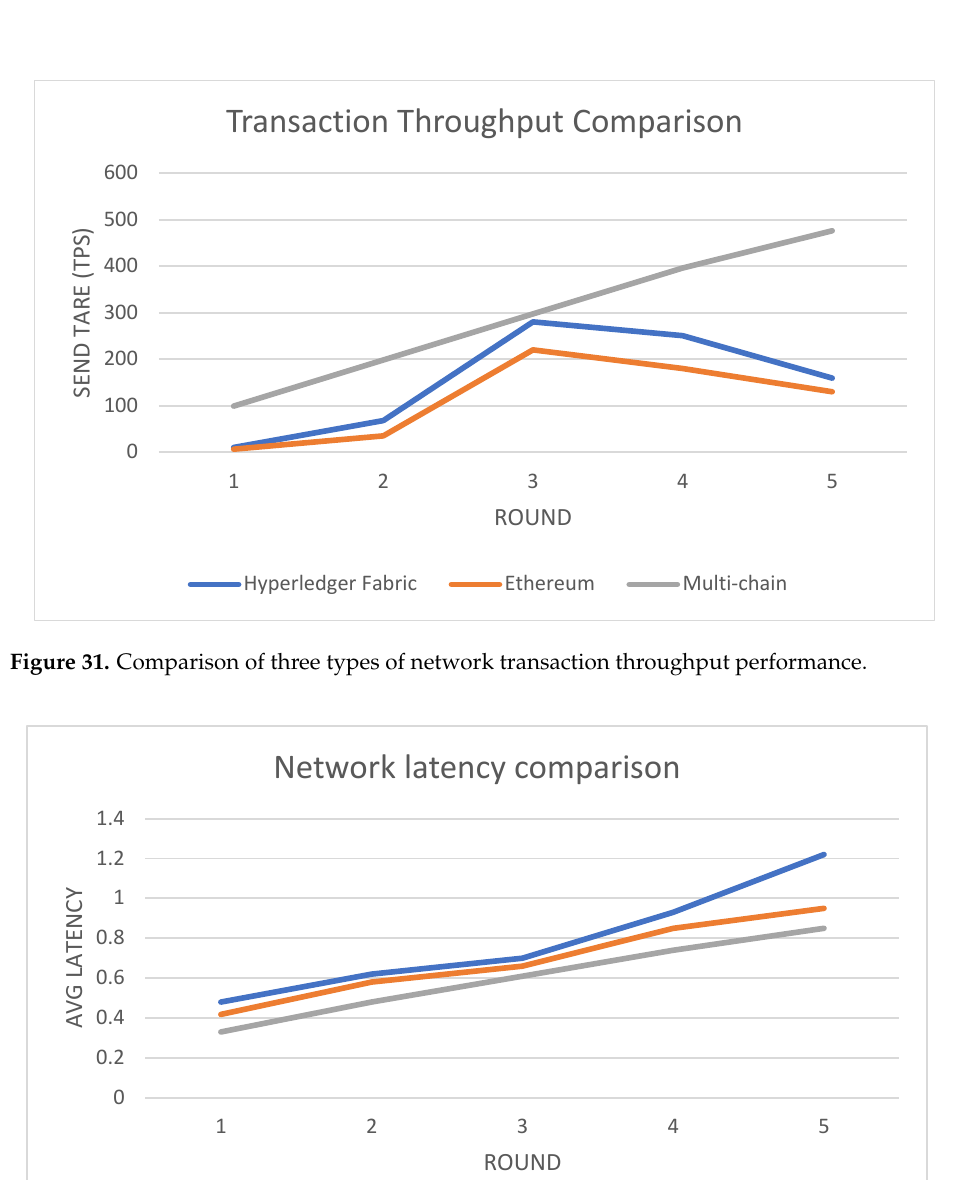
Figure 32. Comparison of three types of network transaction latency performance.